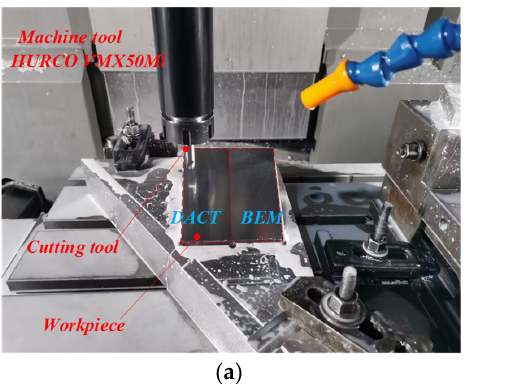
Figure 15. Milling mode of the workpieces: ( a ) inclined plane; ( b ) concave–convex ruled surface.